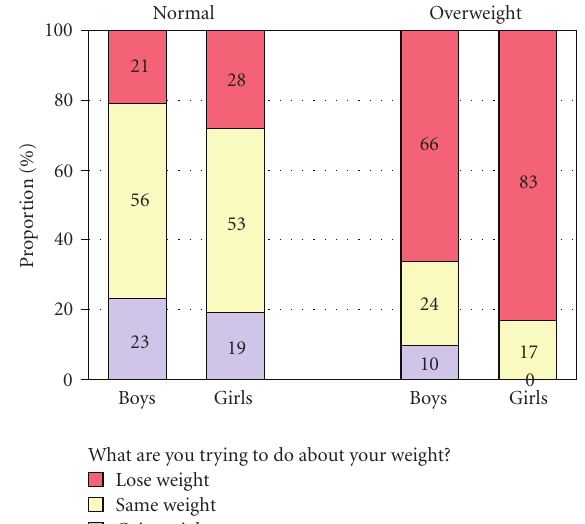
have leaner body image ideals than boys (mean ± SD ideal silhouette: 3 . 78 ± 0 . 88 versus 4 . 01 ± 0 . 83, resp.; P < . 001).